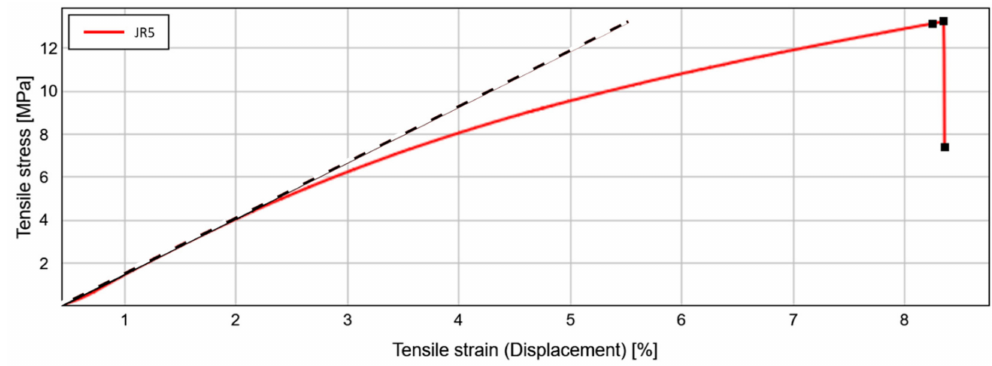
Figure 2. Tensile stress plotted versus tensile strain for the NILcure ® JR5 material.